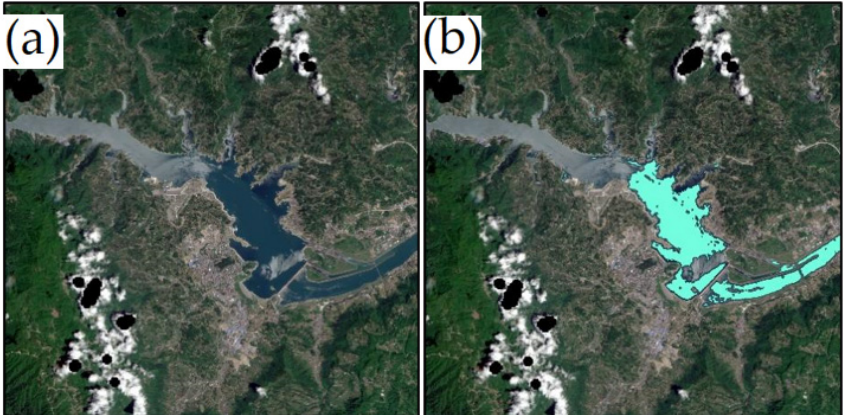
Figure 5. Comparison of images before and after sun glint removal using the SGI (the cyan area shows the extracted water body): ( a ) raw image at the Three Gorges Dam without sun glint removal (10 May 2020); ( b ) processed image at the Three Gorges Dam after removal.